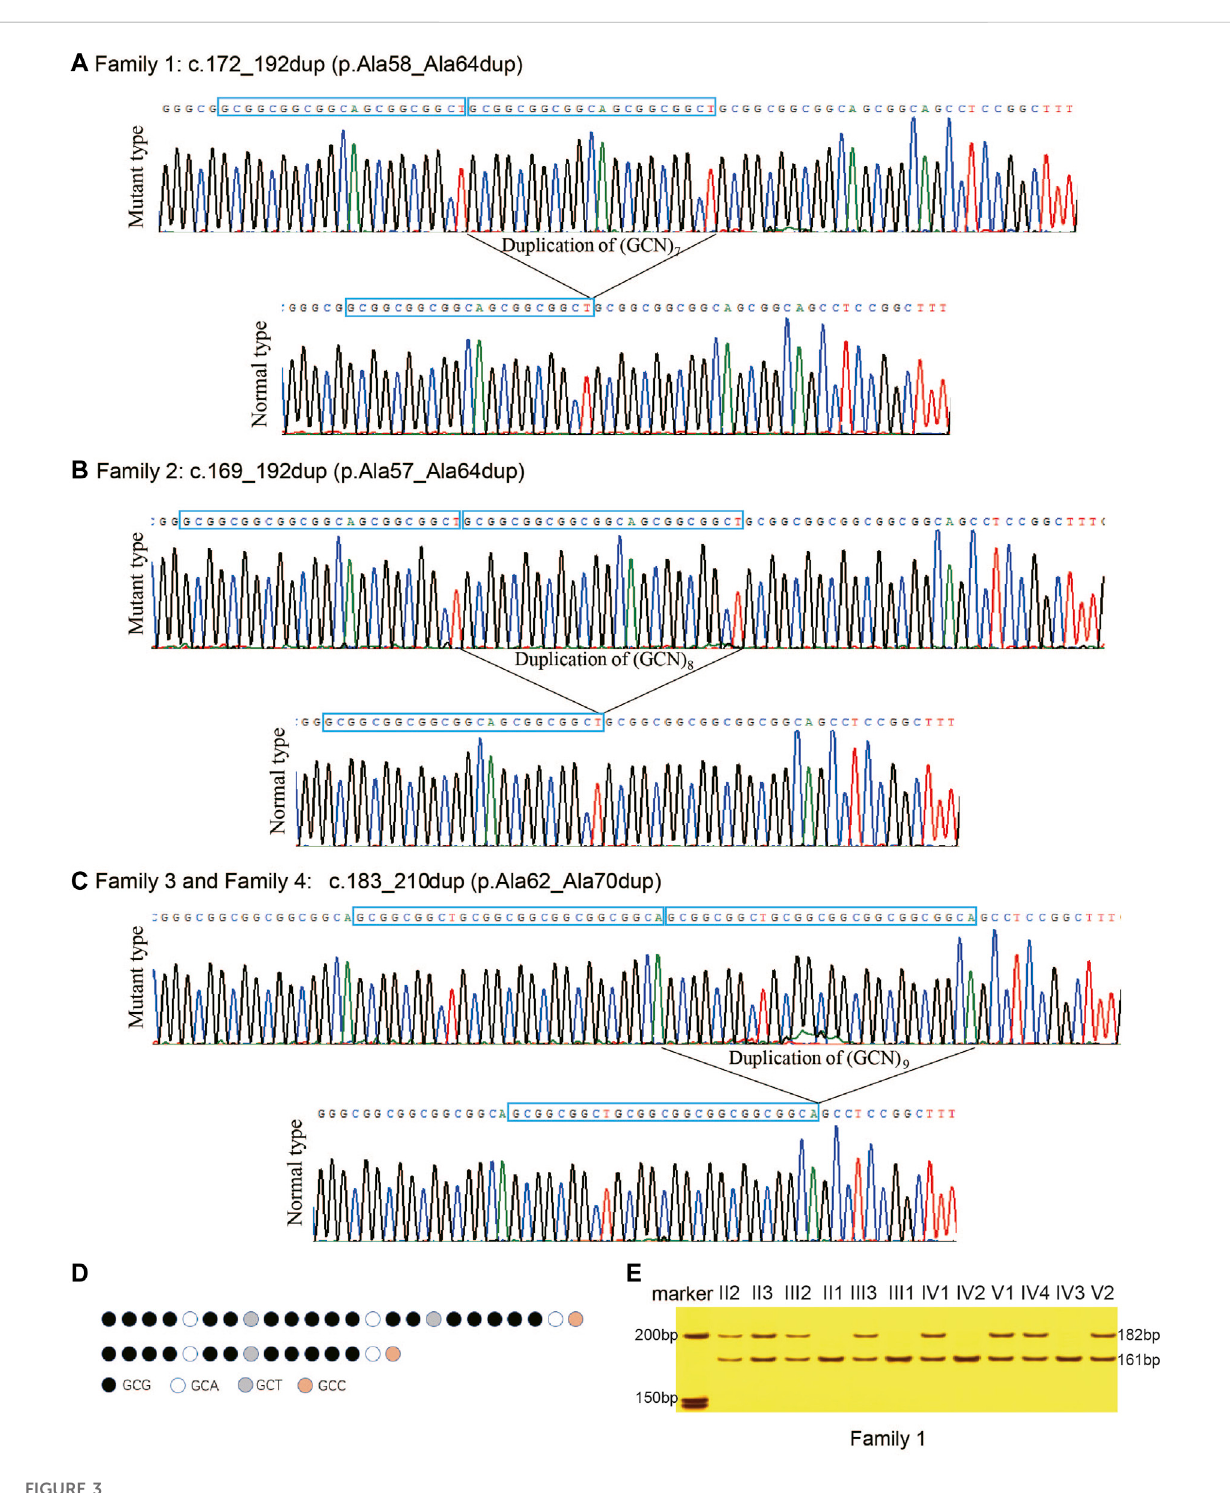
FIGURE 3 Polyalanine expansionsof HOXD13 identi fi edinthefamilieswithsynpolydactyly. (A) Expansionofseven-alanine,c.172_192dup(p.Ala58_Ala64dup), in Family 1. (B) Expansion of eight-alanine, c.169_192dup (p.Ala57_Ala64dup), in Family 2. (C) Expansion of nine-alanine, c.183_210dup (p.Ala62_ Ala70dup),inFamily3andFamily4. (D) TakeFamily4asanexample,patterndiagramofdifferentcodonsin HOXD13 polyalaninetractofthenormalallele and mutant allele with expansion of nine-alanine. (E) Two bands (182bp and 161bp) were separated on 8% neutral polyacrylamide gel. The result showed that all patients had the